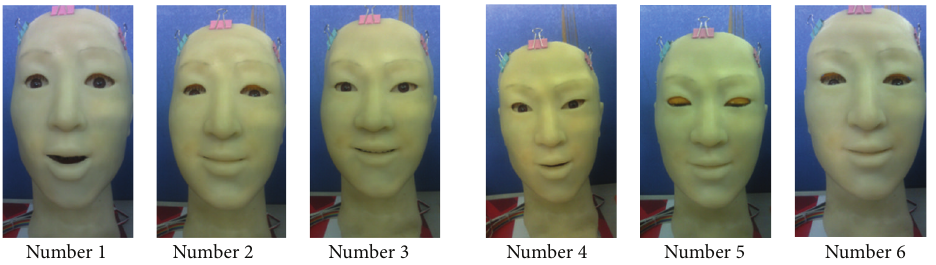
Figure 6: Facial expression of Group